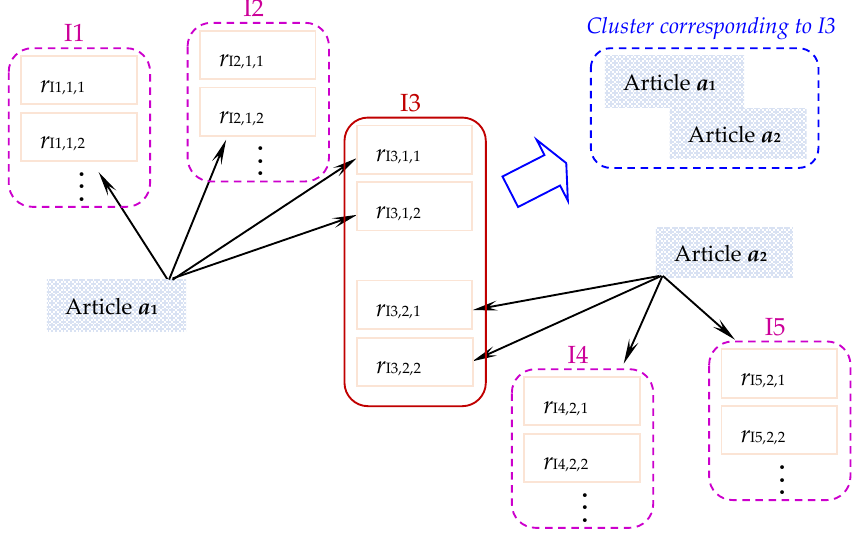
Figure 1. Main idea of issue-based clustering of scholarly article.